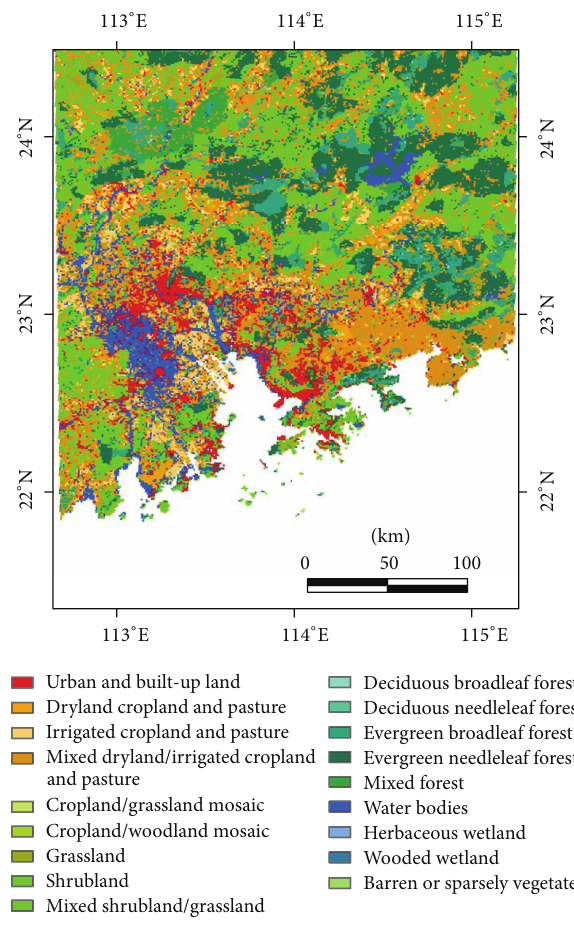
Figure 1: Land use/cover types of the USGS classification system in the PRD in year